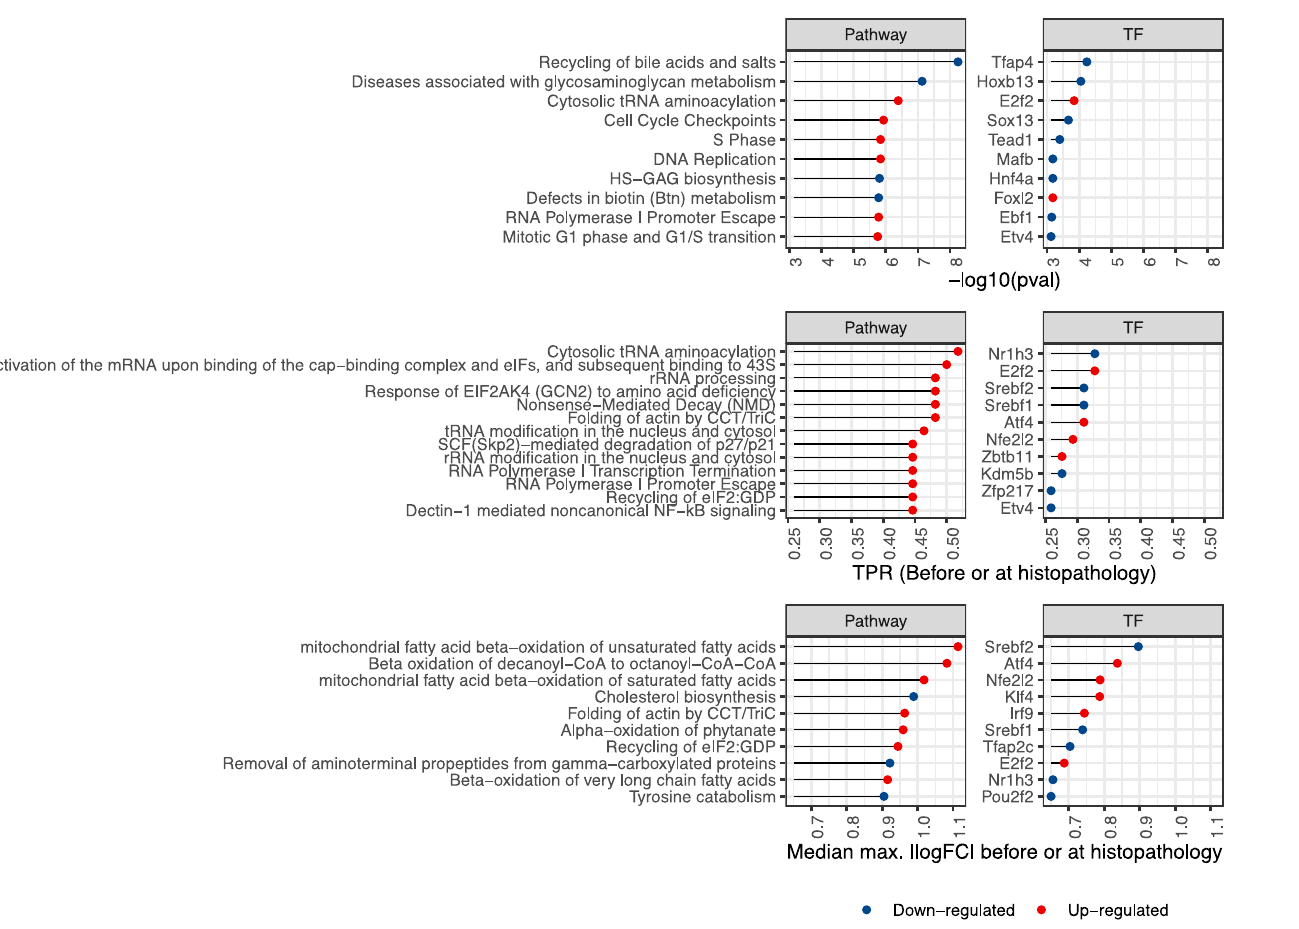
which can be further characterized based on their frequency, significance and logFC.